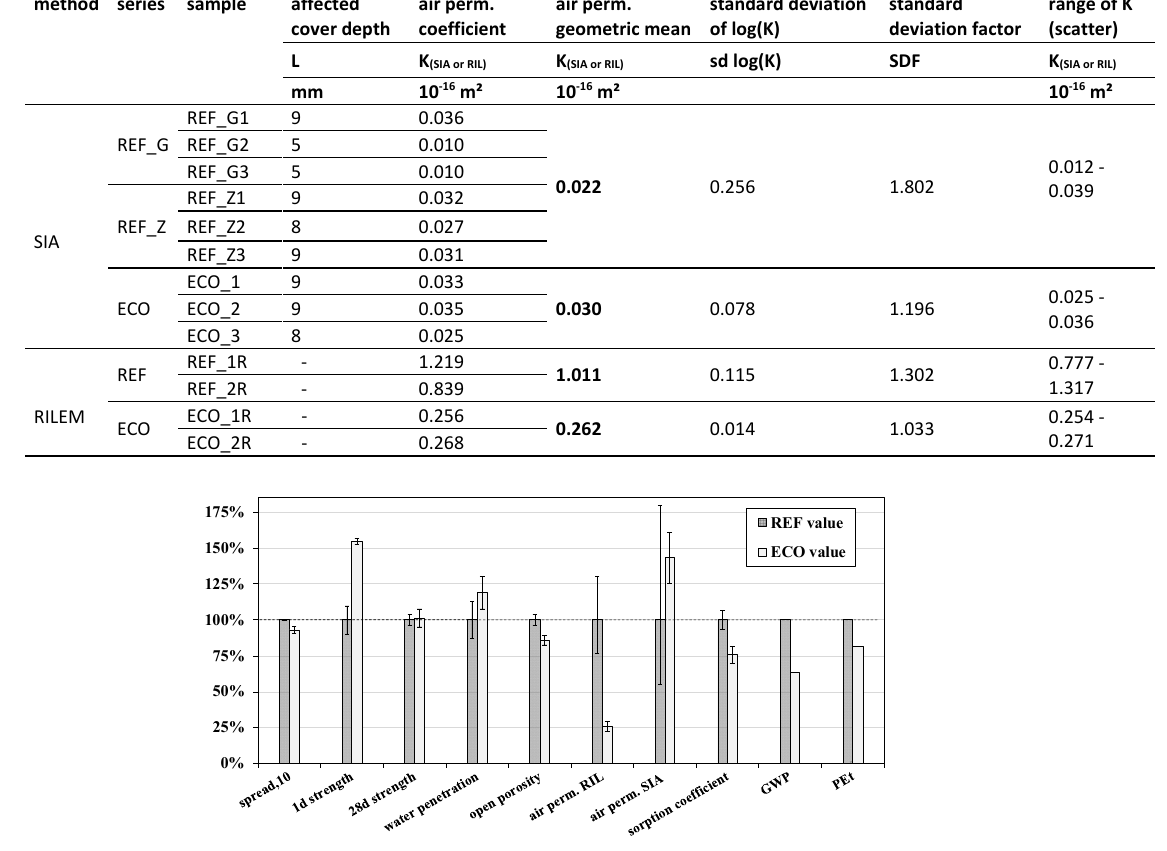
Table 4. Tested air permeability parameters method series sample